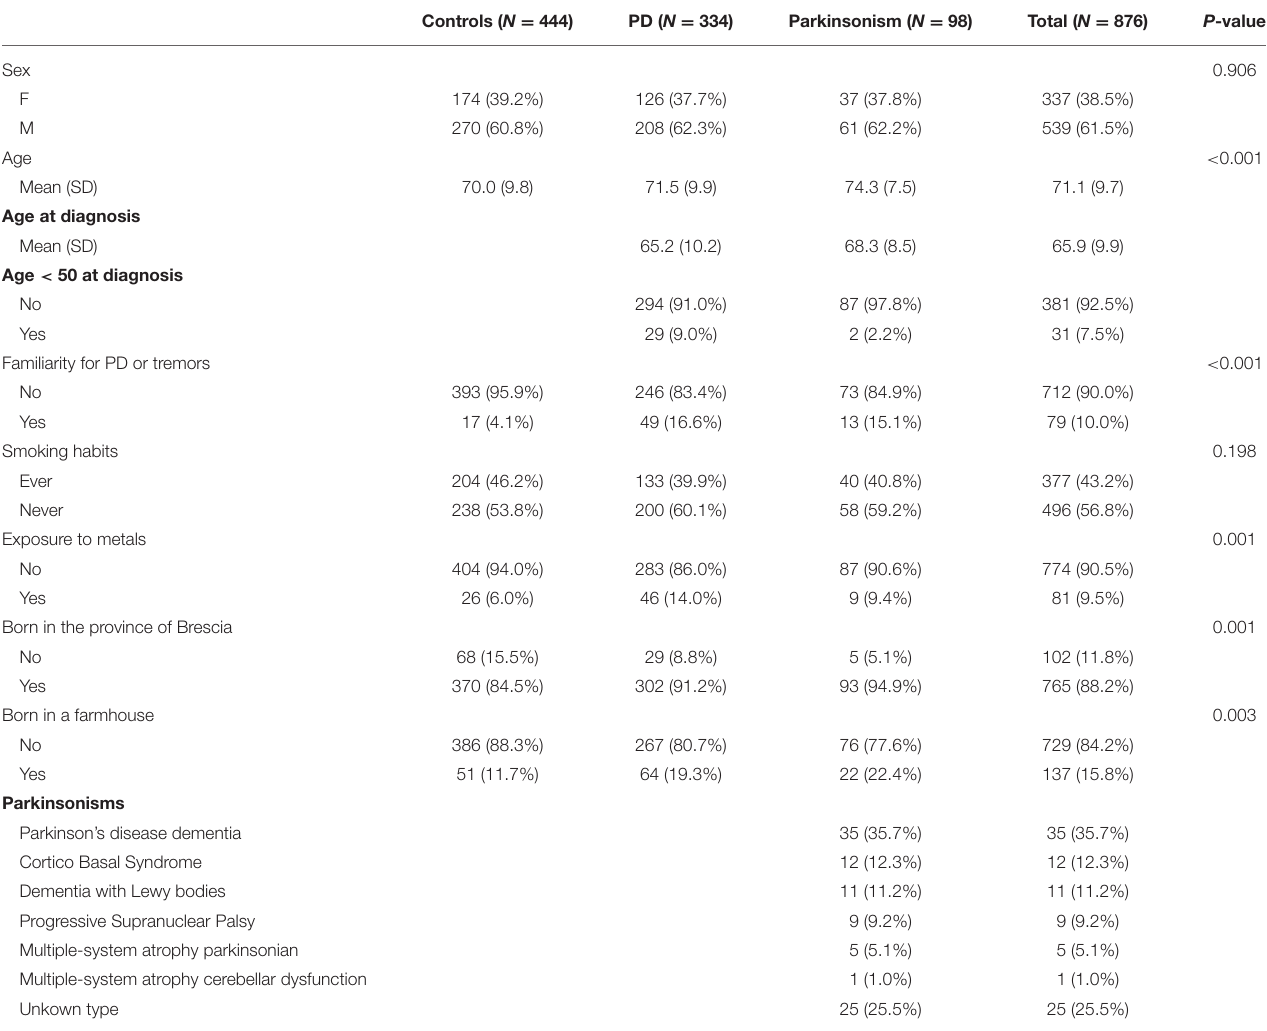
TABLE 1 | Socio-demographics, lifestyle habits and